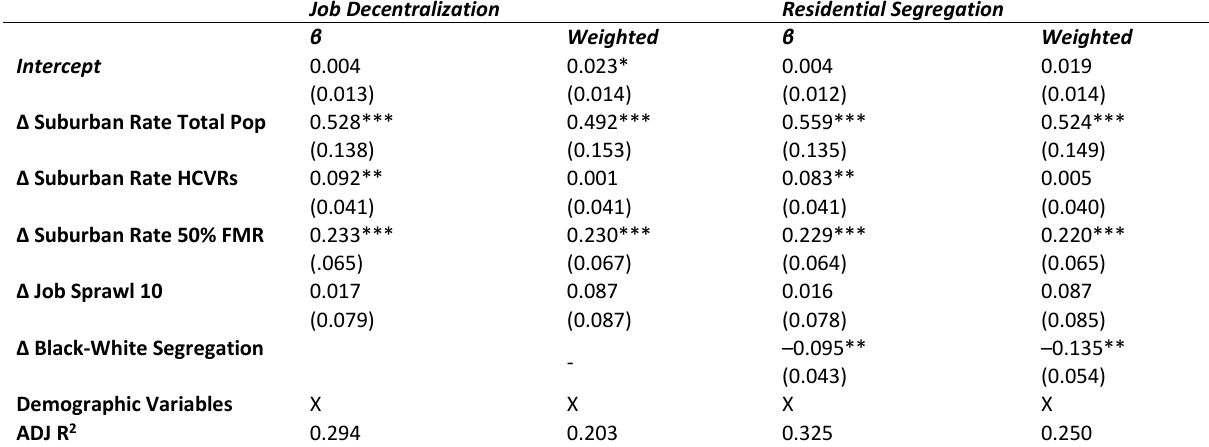
Table 3. 1st difference multivariate regression of suburban share poor, 2000–2008 (N = 100).